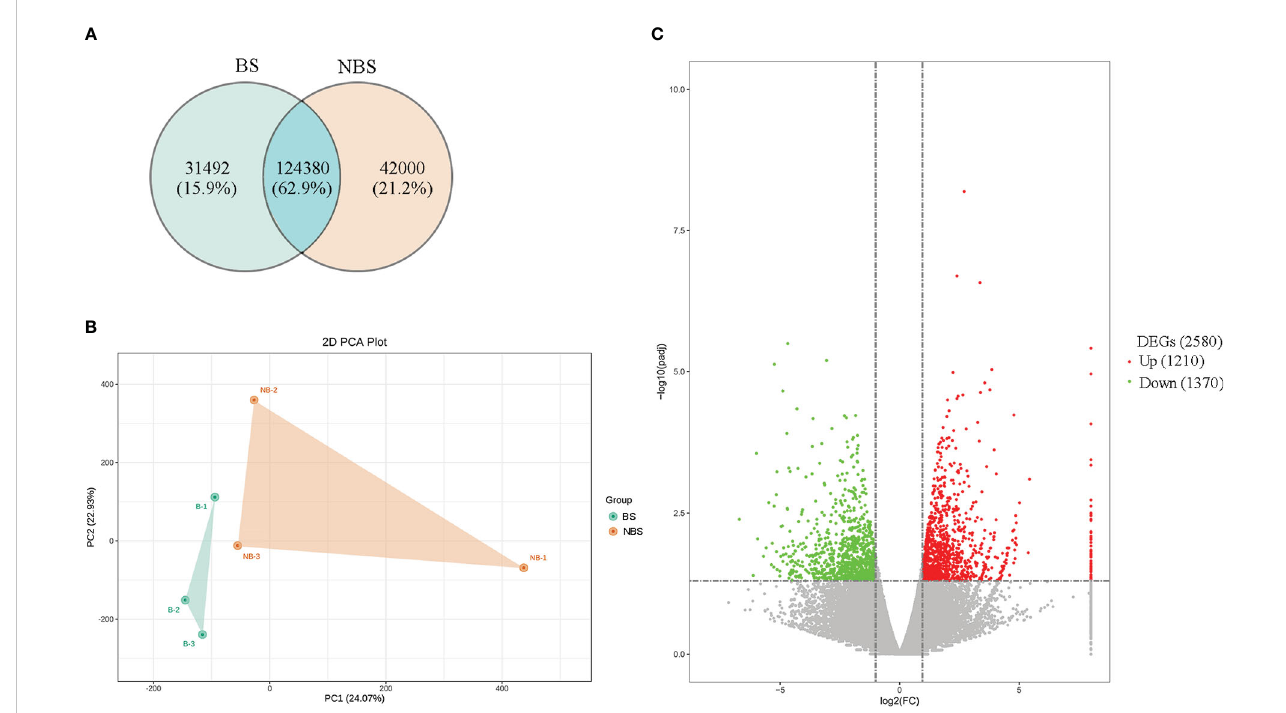
FIGURE 2 (A) The Venn map of expressed genes in the ovaries of breeding and non-breeding seasons. (B) PCA score plot of ovary transcriptomes. BS, breeding season; NBS, non-breeding season. Green point, samples from BS; Orange point, samples from NBS. (C) Volcano map of differential expressed genes (DEGs) in the ovaries of breeding and non-breeding